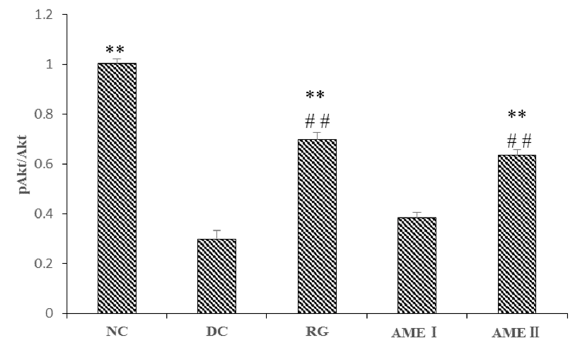
Figure 3. The effect of AME on pAkt, Akt, proteins ( n = 10).